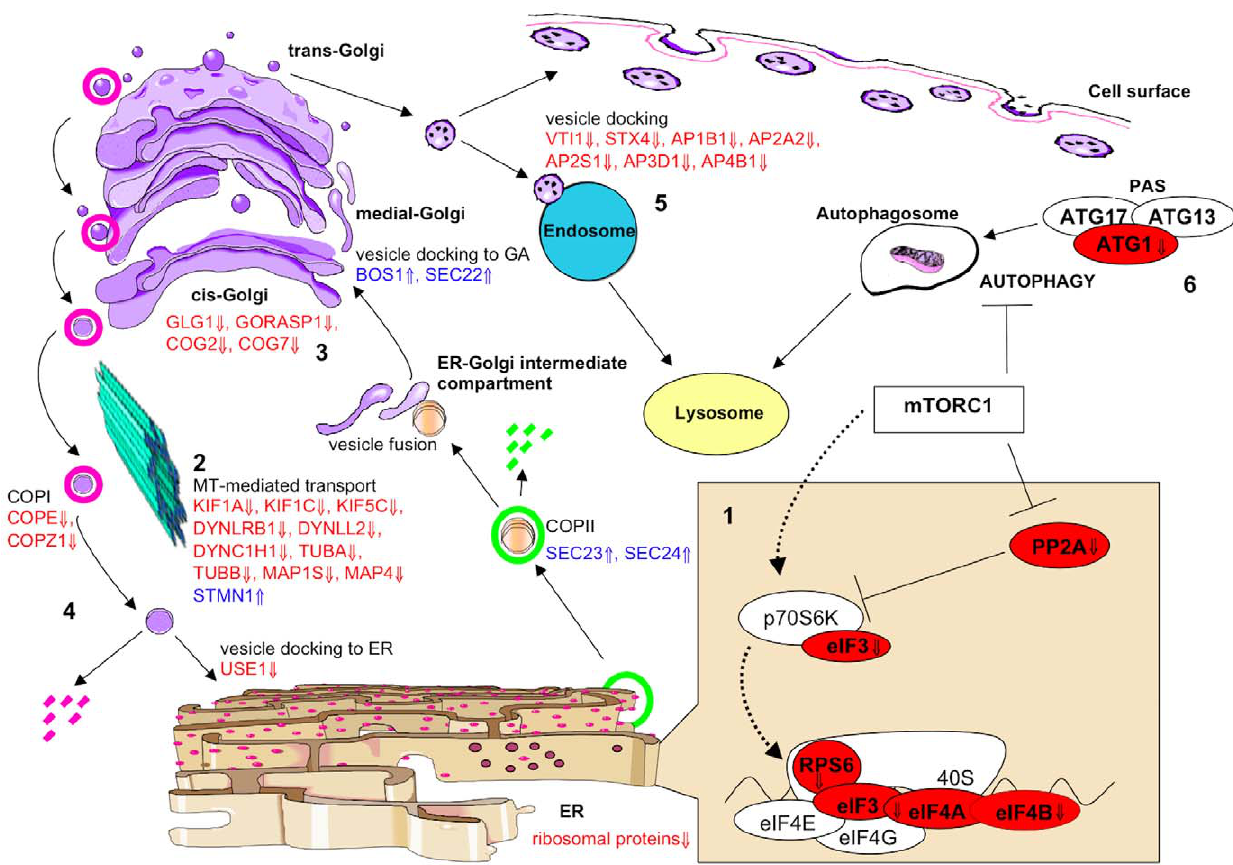
Figure 3. Summary of key gene expression changes to ER and Golgi function, vesicular transport, mTOR signalling and autophagy. The downregulation of multiple transcripts encoding ribosomal proteins, translation initiation factors (eIFs) and the ribosomal subunit, RPS6 suggests a global repression of translation within the cell (1). SEC23 and SEC24 coat vesicles into which immature proteins are packaged and are upregulated. Vesicles are transported along microtubules (MTs) from the ER-Golgi intermediate compartment; however, downregulation of the main components of microtubules, TUBA and TUBB, and the MT-stabilising proteins, MAP1S and MAP4, indicates MT disassembly and therefore disruption to vesicular transport (2). This is enhanced by upregulation of STMN1, a MT-destabilising protein, whose over-expression has also been demonstrated to result in Golgi fragmentation. Downregulation of transcripts maintaining Golgi structure (GLG1, GORASP1, COG2 and COG7) support the hypothesis of Golgi fragmentation (3). COPI is used to coat empty vesicles exiting the Golgi for recycling back to the ER, however, two main constituents, COPE and COPZ1, are downregulated, as is USE1, which is required for vesicle fusion with the ER. These findings predict an eventual deficit of material available to ER for the packaging of newly synthesised proteins (4). There is dysregulation of multiple SNARE transcripts, which are required for vesicle fusion. BOS1 and SEC22 are upregulated, which may be the Golgi’s response to the reduction in vesicles being transported along destabilised microtubules. Multiple SNAREs and adaptor proteins (VTI1, STX4, AP1B1, AP2A2, AP2S1, AP3D1 and AP4B1), which are required for fusion between vesicles carrying mature proteins and the cell surface, endosomes and lysosomes, are downregulated, predicting impairment in the delivery of proteins throughout the cell (5). Finally, inhibition of autophagy by the mTORC1 complex and downregulation of ATG1, which forms the phagophore assembly site (PAS) with ATG17 and ATG13 to initiate autophagy, indicates a decrease in the clearance of cellular debris which may result in cytosolic accumulations and contribute to motor neuron injury